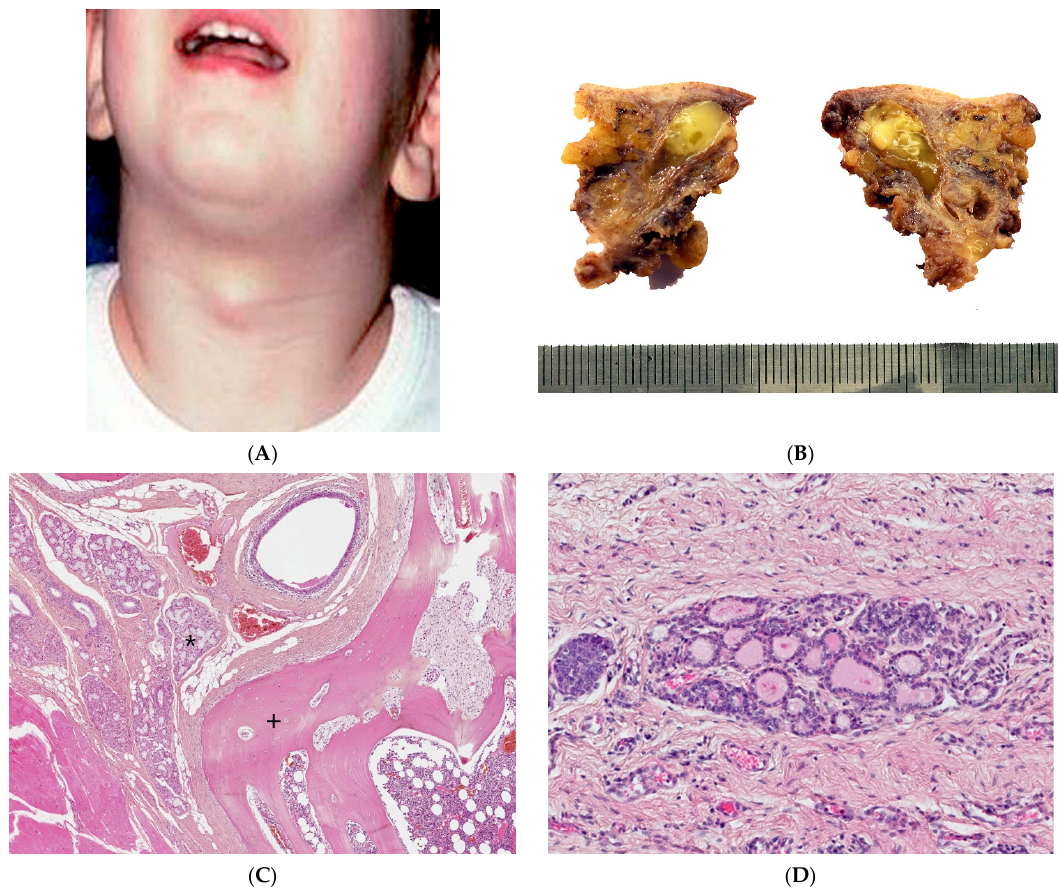
Figure 2. Thyroglossal duct cyst. ( A ) Clinical examination: typical picture of a non-infected thyroglossal duct cyst presenting as a midline neck mass. ( B ) Gross examination: cystic lumen filled with gelatinous and inflammatory material. ( C ) (H.E.S). Small cystic structure lined by ciliated pseudostratified columnar epithelium; mucous glands (*) on the left; hyoid bone (+) on the right, in close relation to the cyst. ( D ) (H.E.S), ectopic thyroid follicles in the cystic wall.